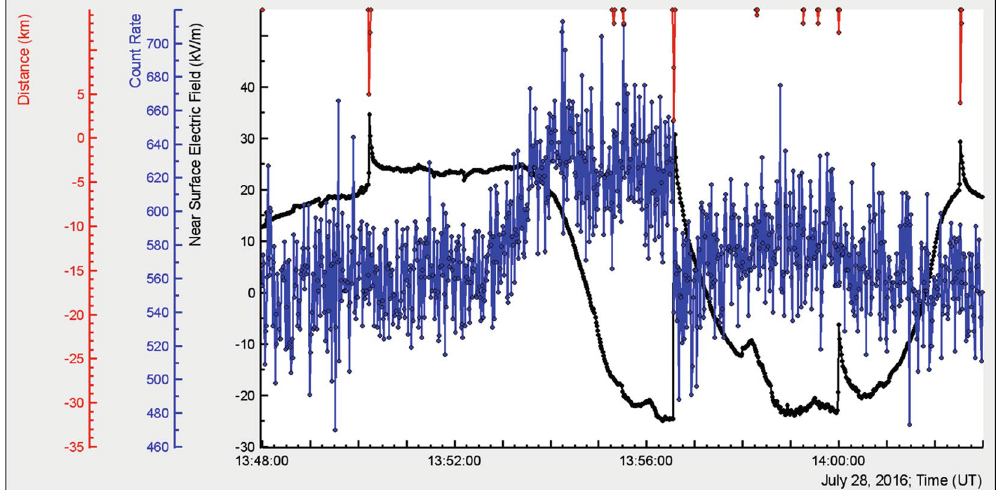
Figure 2. One second time series of 1 cm thick scintillator of STAND1 detector located nearby MAKET experimental hall. Negative lightning abruptly terminated TGE.